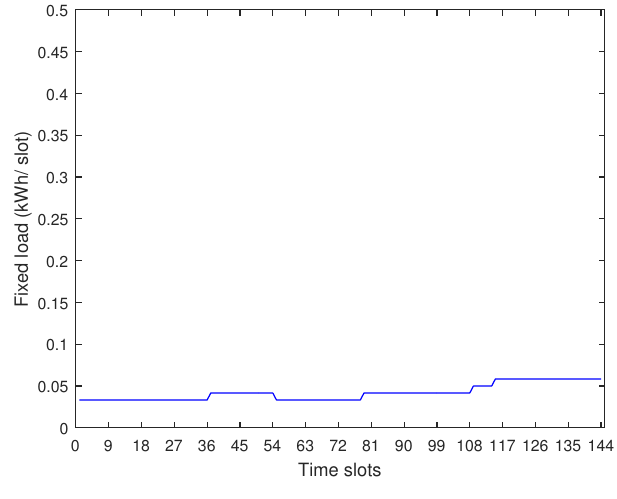
Figure 2. Fixed load profile for a smart home. Table 3. SHAs and scheduling specifications for the DS and MS